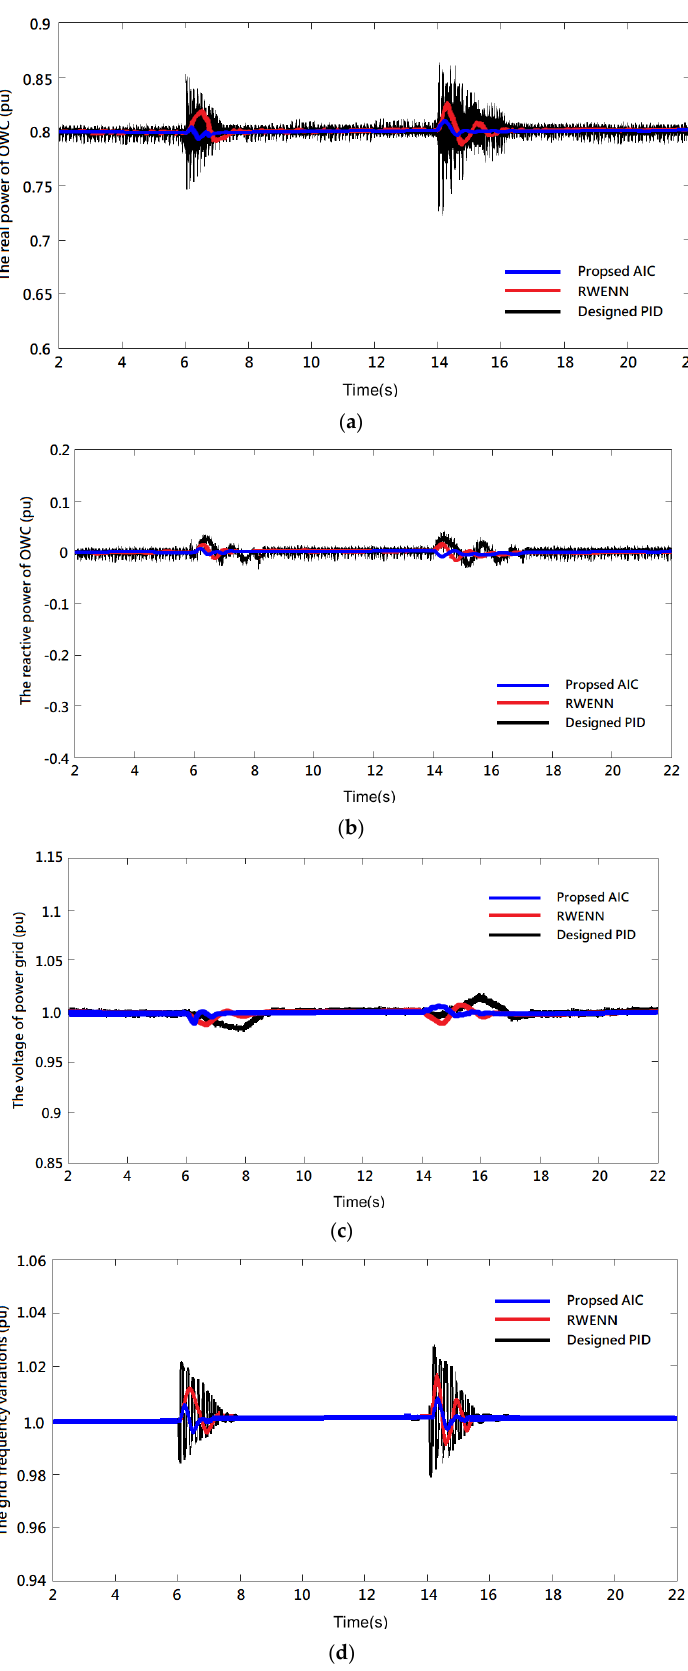
Figure 5. Dynamic responses of the studied system with load disturbance: ( a ) turbine speed, ( b ) AC line voltage, ( c ) DC link voltage, and ( d ) grid side real power.